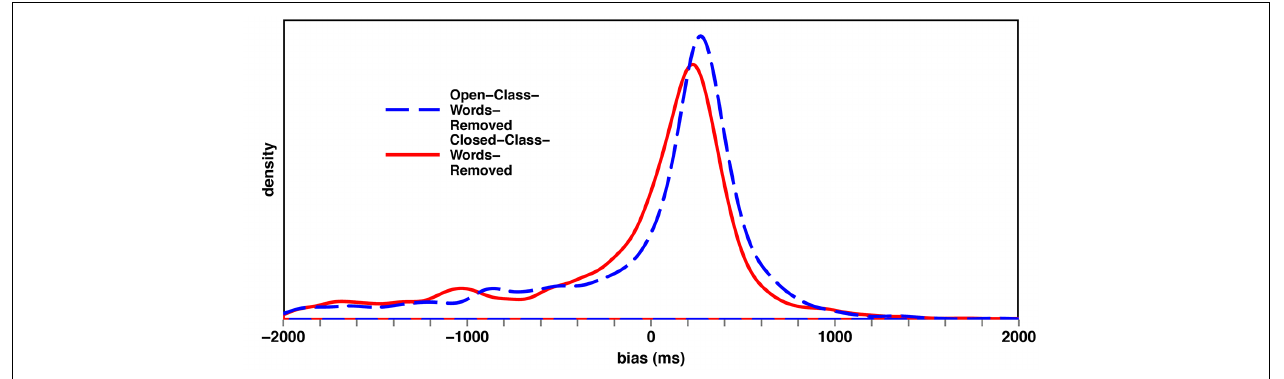
FIGURE 9 | Density plot of the BIAS distribution (in ms) of the Open-Class-Words-Removed and the Closed-Class-Words-Removed conditions. A paired t -test revealed that the difference of the means of the two conditions was significant [ t (99) = − 3.23, p <